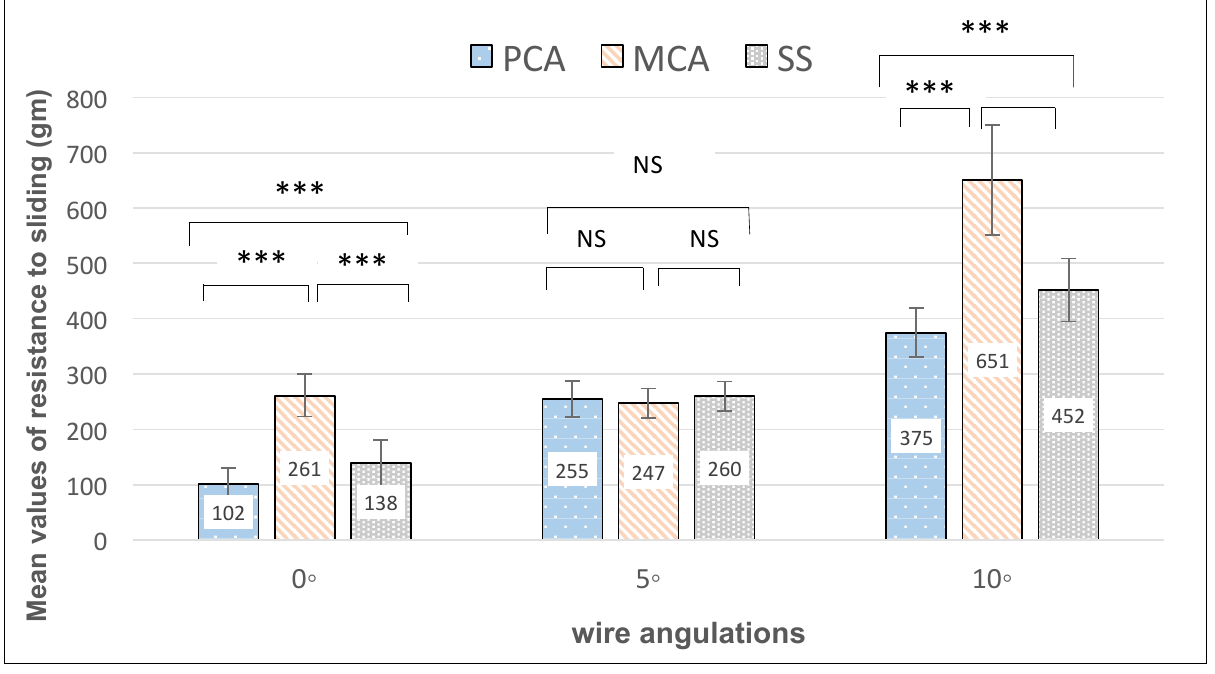
Figure 3. Bar graph of the comparison between mean values of frictional resistance among bracket types in all three wire angulations (dry environment). (PCA) polycrystalline alumina brackets. (MCA) monocrystalline ceramic brackets. (SS) stainless steel brackets. *** p < 0.001.